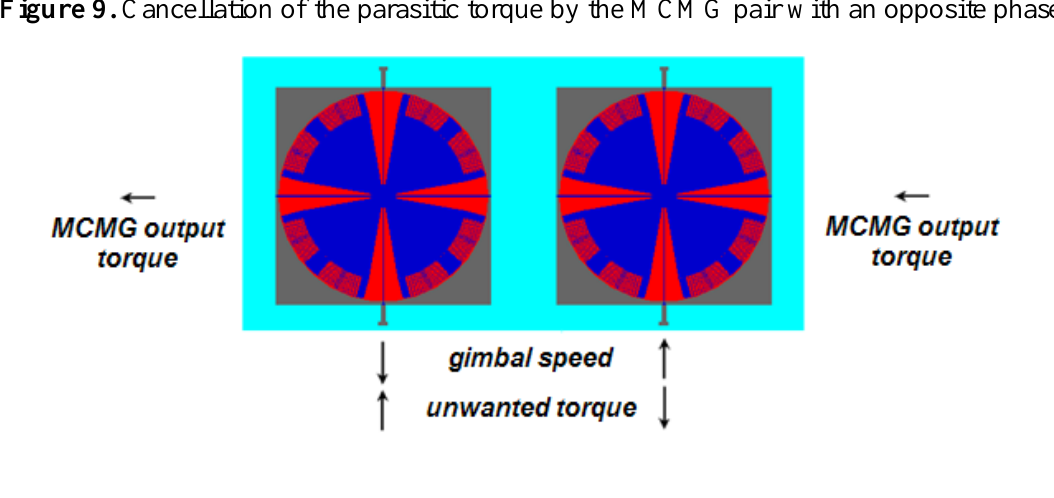
Figure 9. Cancellation of the parasitic torque by the MCMG pair with an opposite phase.